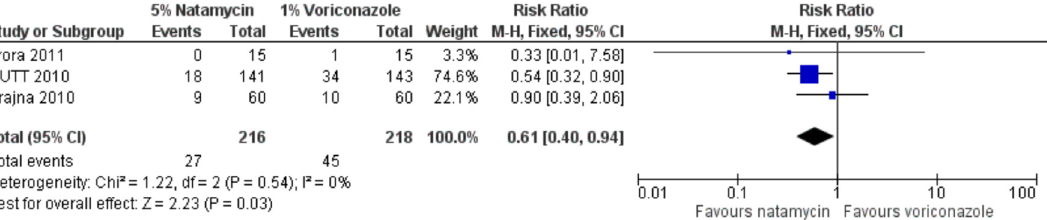
Figure 2. Forest plot of topical natamycin 5% versus voriconazole 1% (outcome: corneal perforation). Reproduced from FlorCruz NV, Evans JR. Medical interventions for fungal keratitis. The Cochrane Database of Systematic Reviews 2015; 4 : CD004241 with permission from John Wiley and Sons [ 5] .